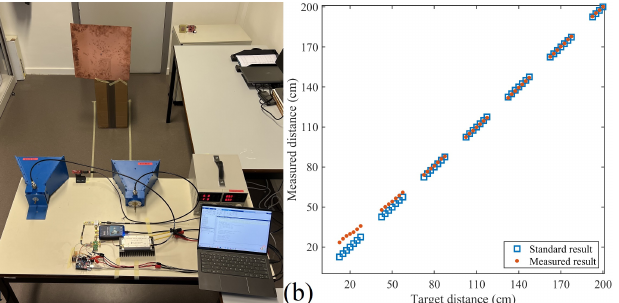
Figure 4. ( a ) Experimental setup for SFCW range test. ( b ) Result of SFCW radar